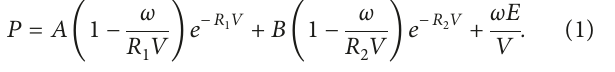
Figure 2: The tunnel dimension plot (cm).